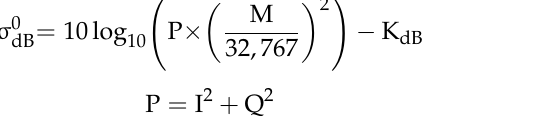
Figure 2. The process of image preprocessing.